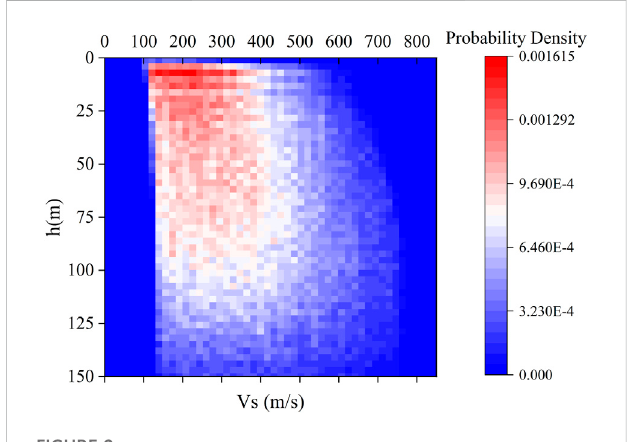
FIGURE 2 Velocity probability density map.